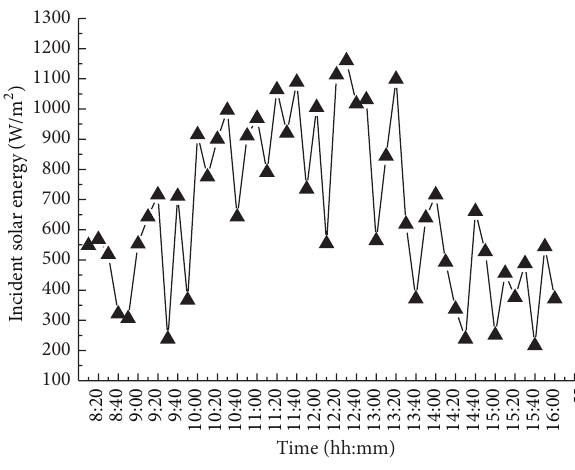
Figure 6: Incident solar energy versus testing time.